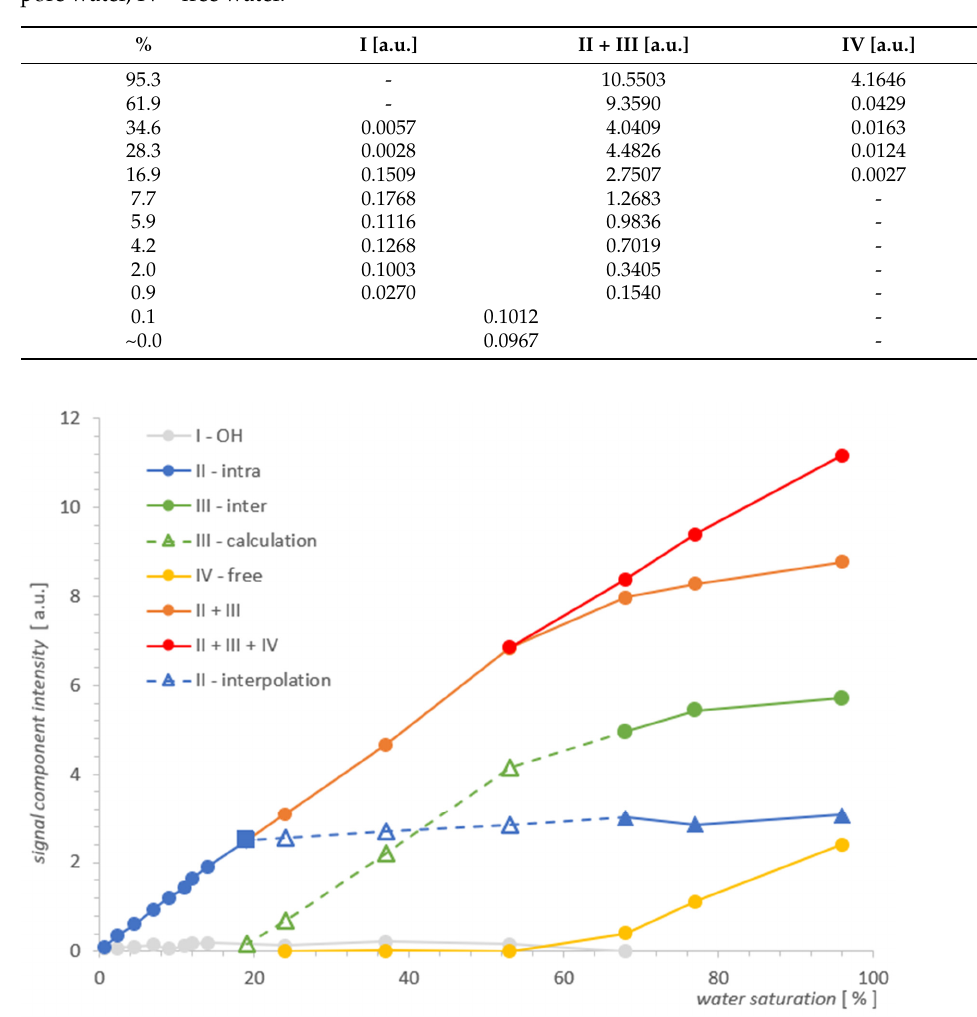
Figure 5. Individual contributions of water in MCM-41 as a function of total water saturation. The square point denotes the water saturation at which the inter water III vanishes, as seen from the comparison of the two spectra for MCM-41 and SBA-15 where both line widths are comparable.